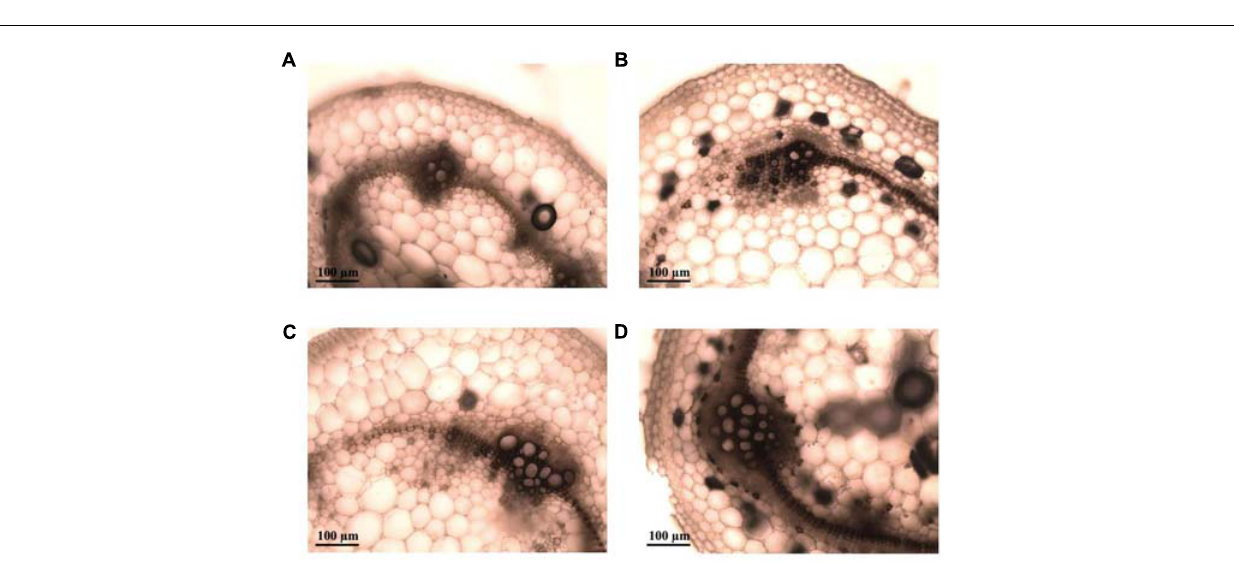
FIGURE 8 | Representative light micrographs of diamino benzidine (DAB) stained stem cross-sections of plants from the susceptible potato cultivar S. tuberosum cv. Chieftain and the tolerant clone 09509.6. Reactive oxygen species (ROS) production was evaluated 24 h after stem inoculation with R. solanacearum UY031 strain and compared to mock inoculated plants. DAB forms a brown precipitate in presence of hydrogen peroxide, indicating ROS production. (A) Mock inoculated Chieftain plant. (B) Mock inoculated 09509.6 plant. (C) Chieftain plant inoculated with R. solanacearum . (D) 09509.6 plant inoculated with R. solanacearum